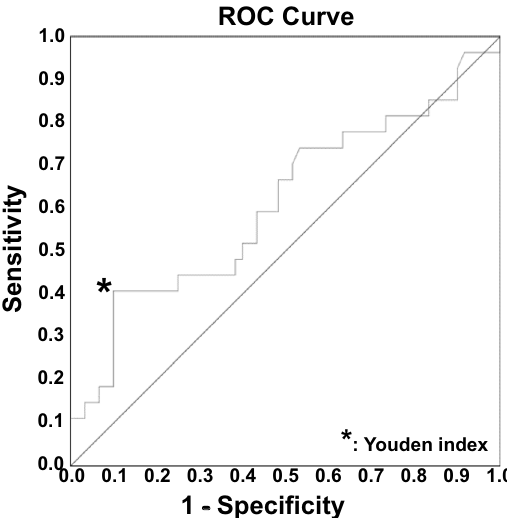
Figure 1. Receiver operating characteristics (ROC) curve. The ROC analysis shows that the cutoff value of the average baseball load is 324.4 min per day (P = 0.10, area under the curve [AOC] = 0.60; Fig.